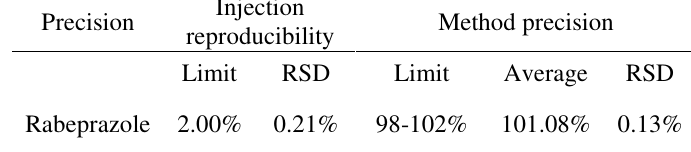
Table 4. Specificity